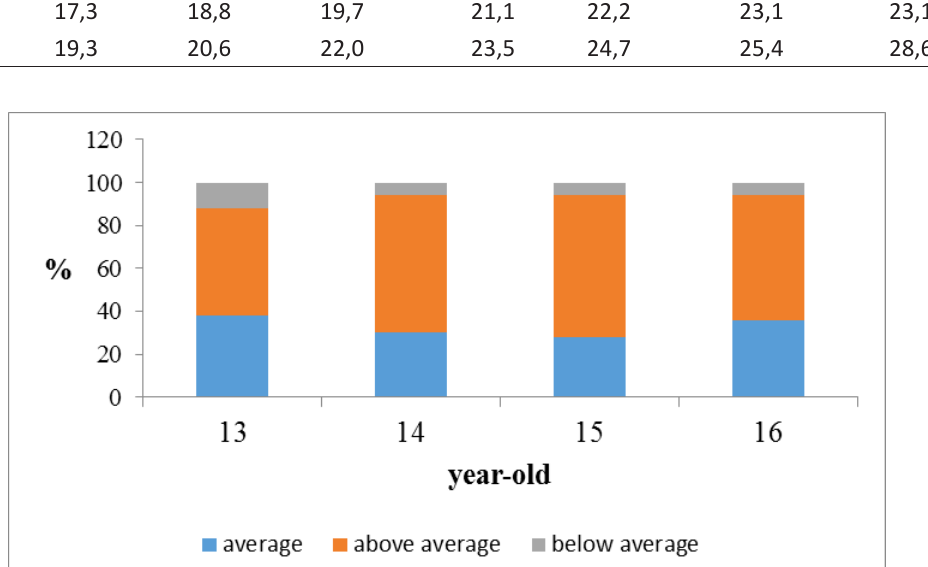
Fig. 1. In-group distribution of hockey players from 13 to 16 years old according to the body length relative to